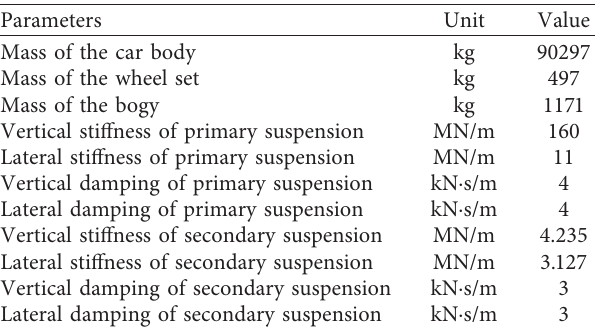
Table 1: Parameters of C80 freight